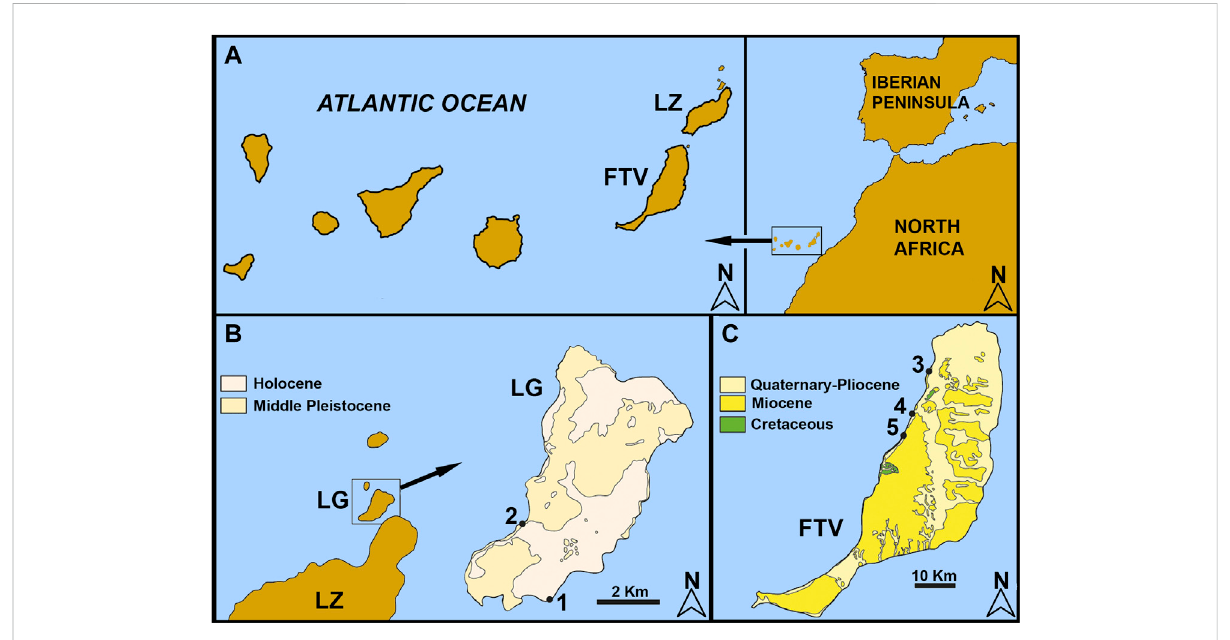
FIGURE 1 Geographic location of the studied material. (A) theCanary Islands and their global location. (B) location and geology ofLa Graciosa Islandwith fossiliferous sites. (C) geological map of Fuerteventura Island and paleontological site location. 1, Baja del Corral; 2, Playa del Salado; 3, Aljibe de la Cueva; 4, Barranco León; 5, Playa del